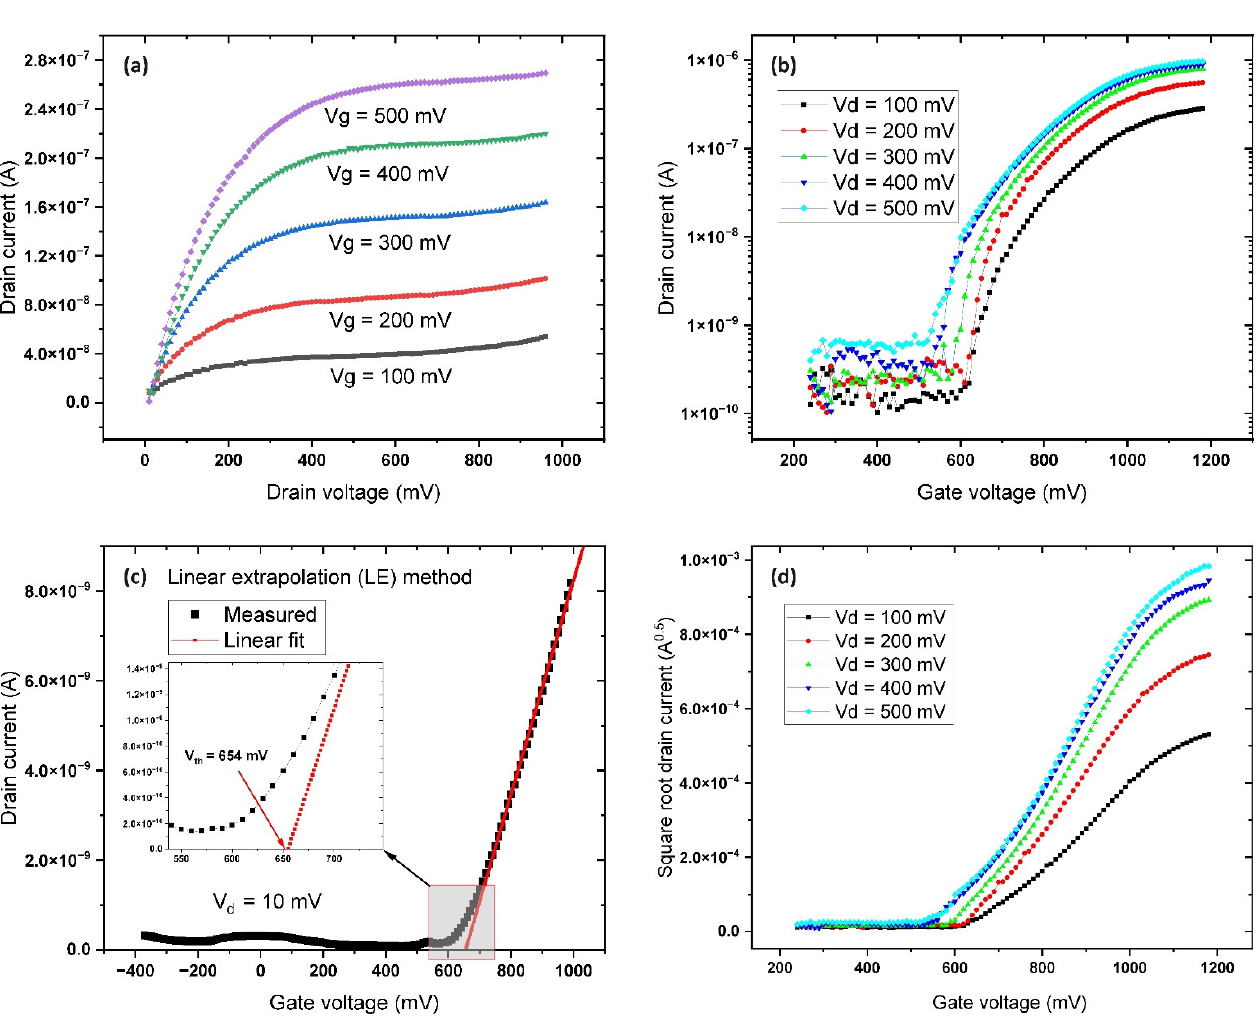
Figure 5. ( a ) Output characteristics (I d –V d ) of the WGFET at gate voltages ranging from 100 mV to 500 mV and drain voltages from 0 V to 1 V; ( b ) logarithmic representation of transfer characteristics (I d –V g ) of the thin-film transistor; ( c ) results from the extrapolation of the linear region (ELR) method for determination of V th ; ( d ) square root plot of the drain current vs. gate voltage.